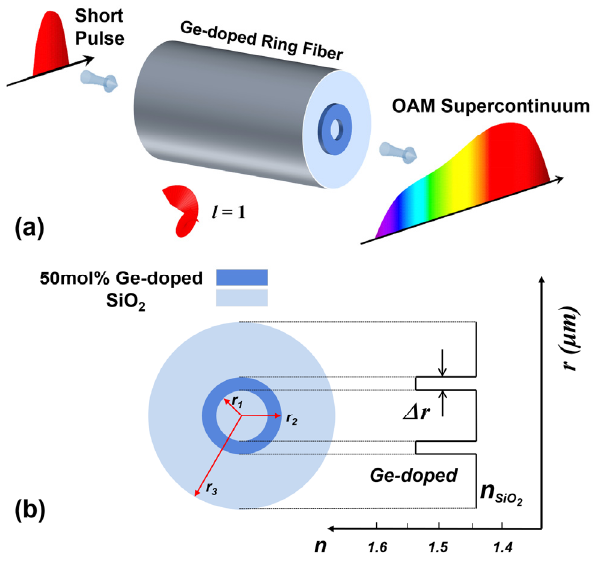
Figure 1. ( a ) Schematic diagram of SC generation; ( b ) Cross-section of the Ge-doped silica